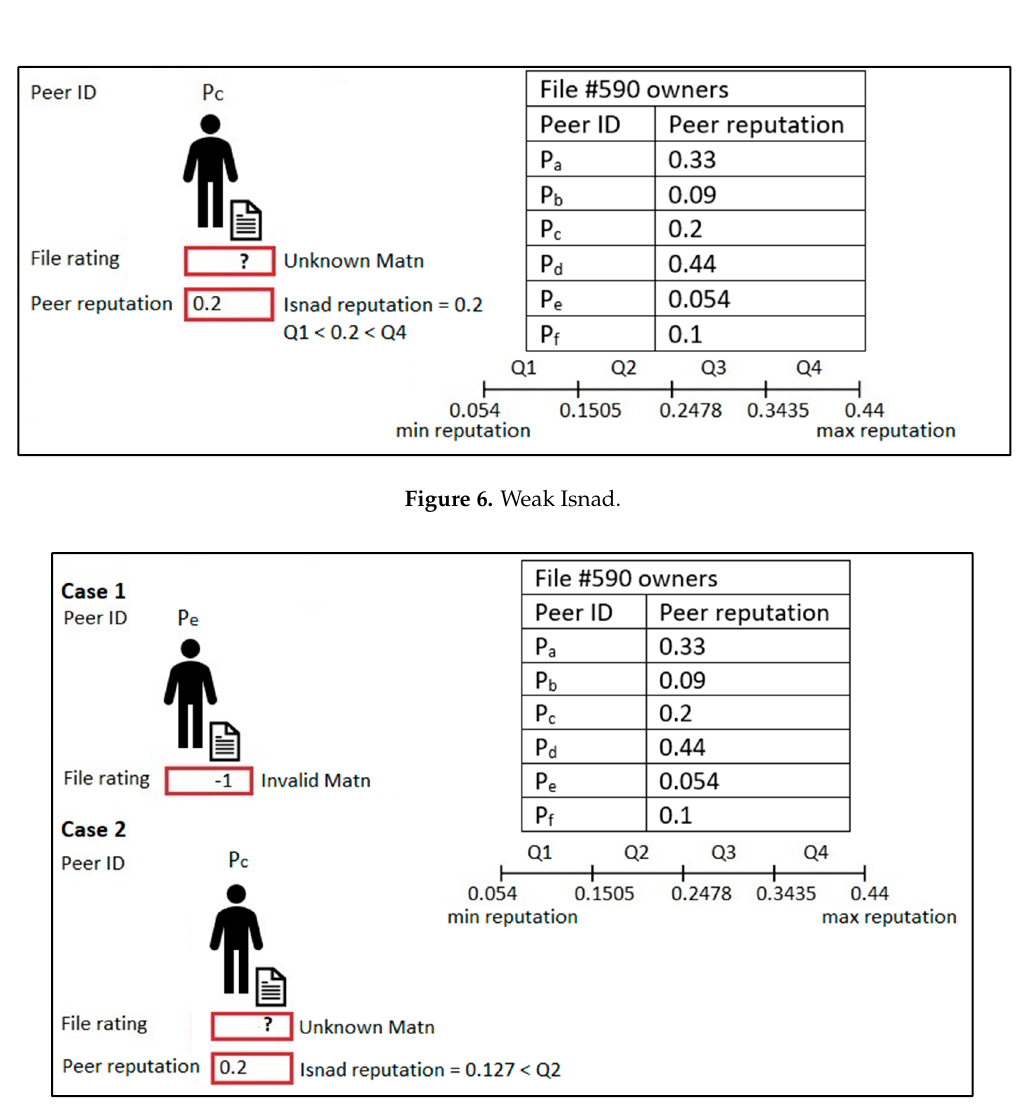
Figure 7. Bad Isnad.